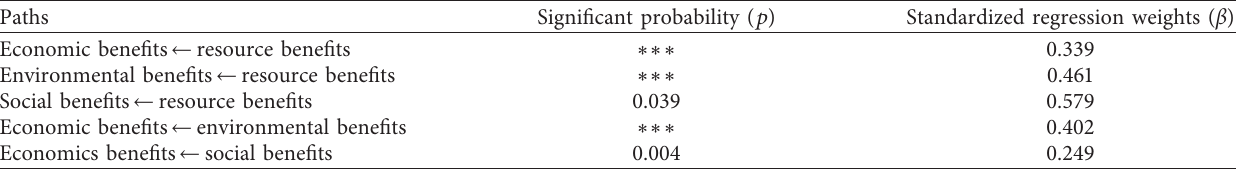
Table 7: Path coefficients and their significant values.